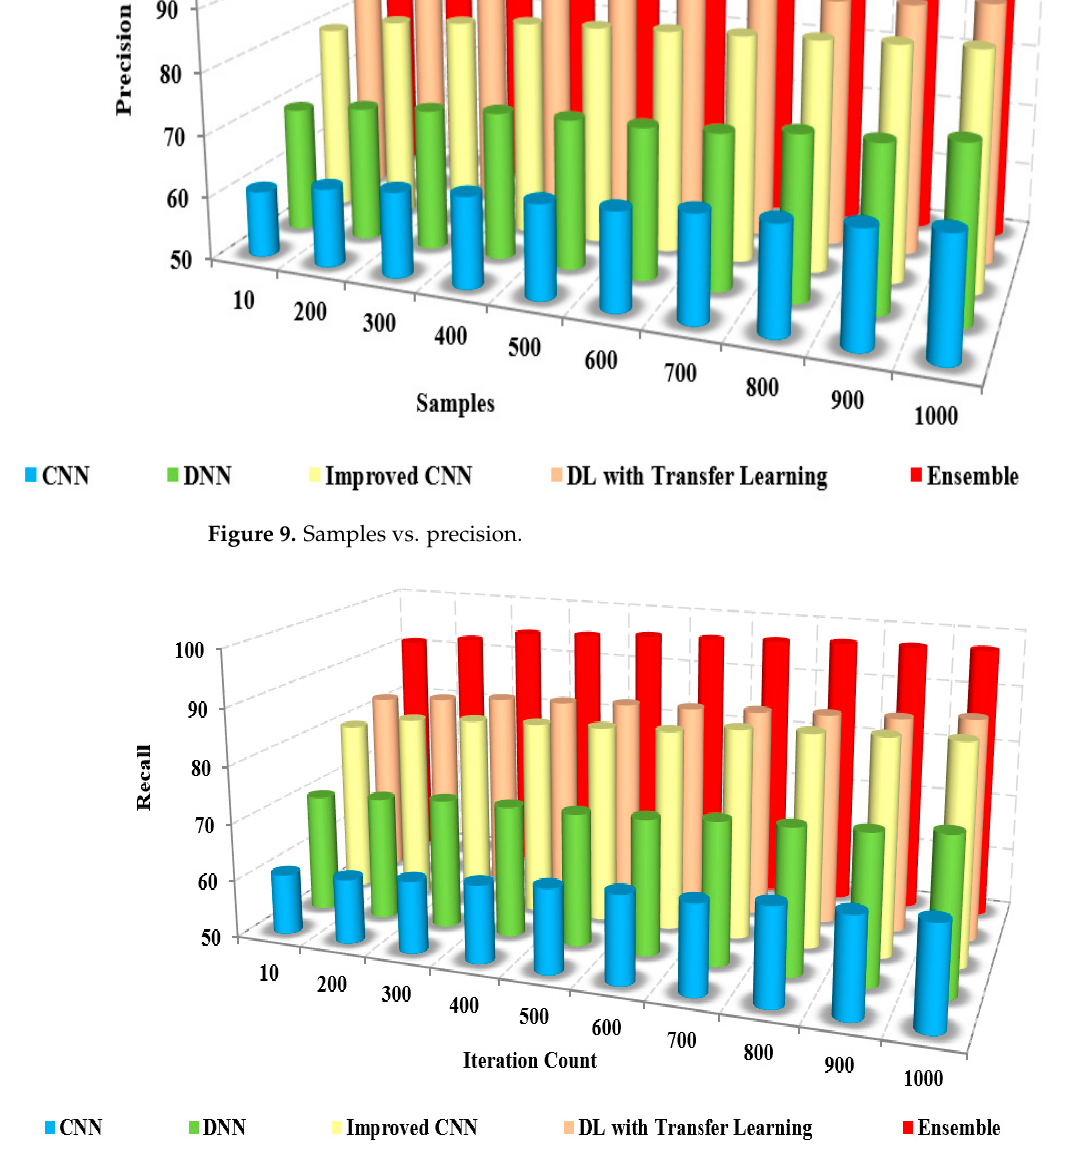
Figure 10. Iteration count vs. recall. Table 4.